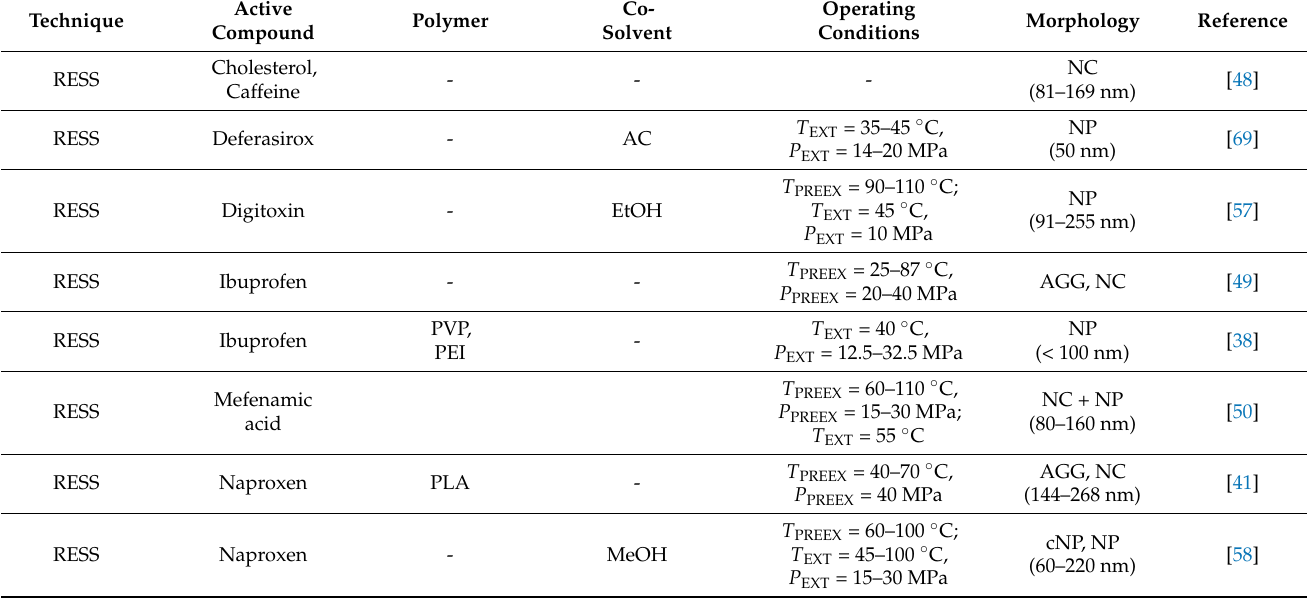
Table 1. An overview of nanoparticle production by using CO 2 as a solvent. NP: nanoparticles; NC: nanocrystals; c: coa- lescing particles; AGG: aggregates; T PREEX : pre-expansion temperature; P PREEX : pre-expansion pressure; T EXT : extraction temperature; P EXT : extraction pressure; T EXP : expansion temperature; P EXP : expansion pressure; AH: amiodarone hy- drochloride; TBTPP: fluorinated tetraphenylporphyrin; BSA: bovine serum albumin; HPMC: hydroxypropylmethylcellulose; PEG: poly(ethylene glycol); PEI: polyethylene amine; PLA: polylactic acid; PLLA: poly( L -lactide); PVA: poly(vinyl